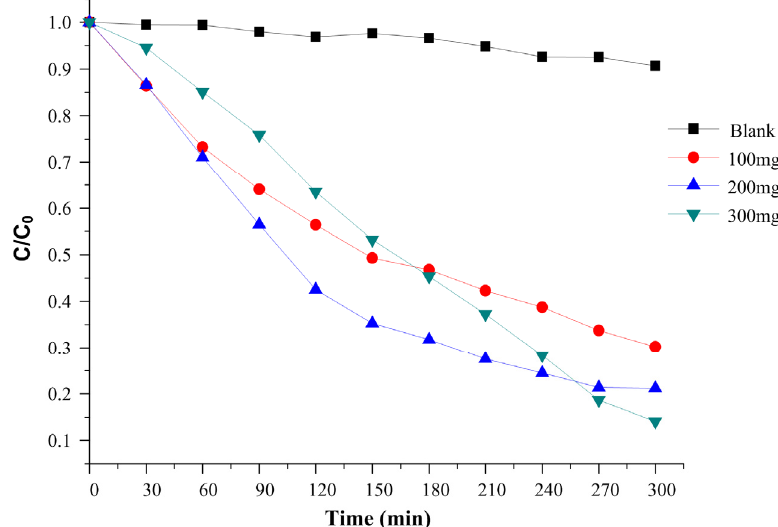
Figure 13. Effect of catalyst amount on the MB decolorization process (ZnS:CdS